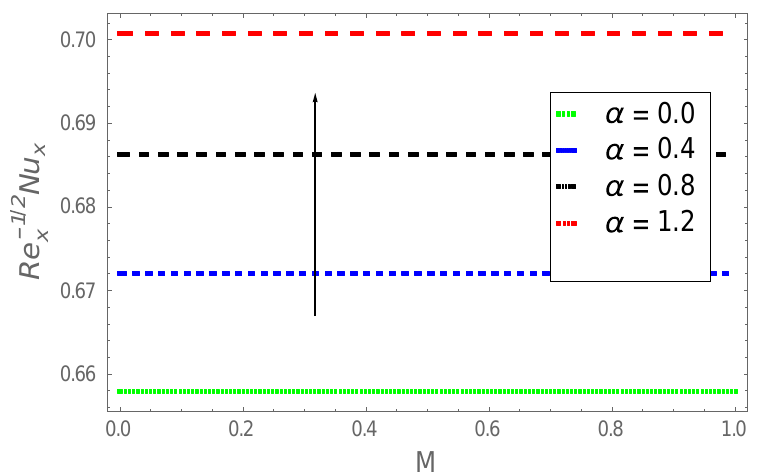
Figure 32. Consequence of Re 0.5 x Cf x via α and M .